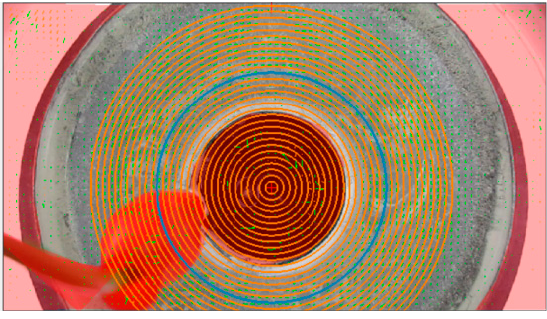
Figure 9. Circle series submitted to velocity measurement.